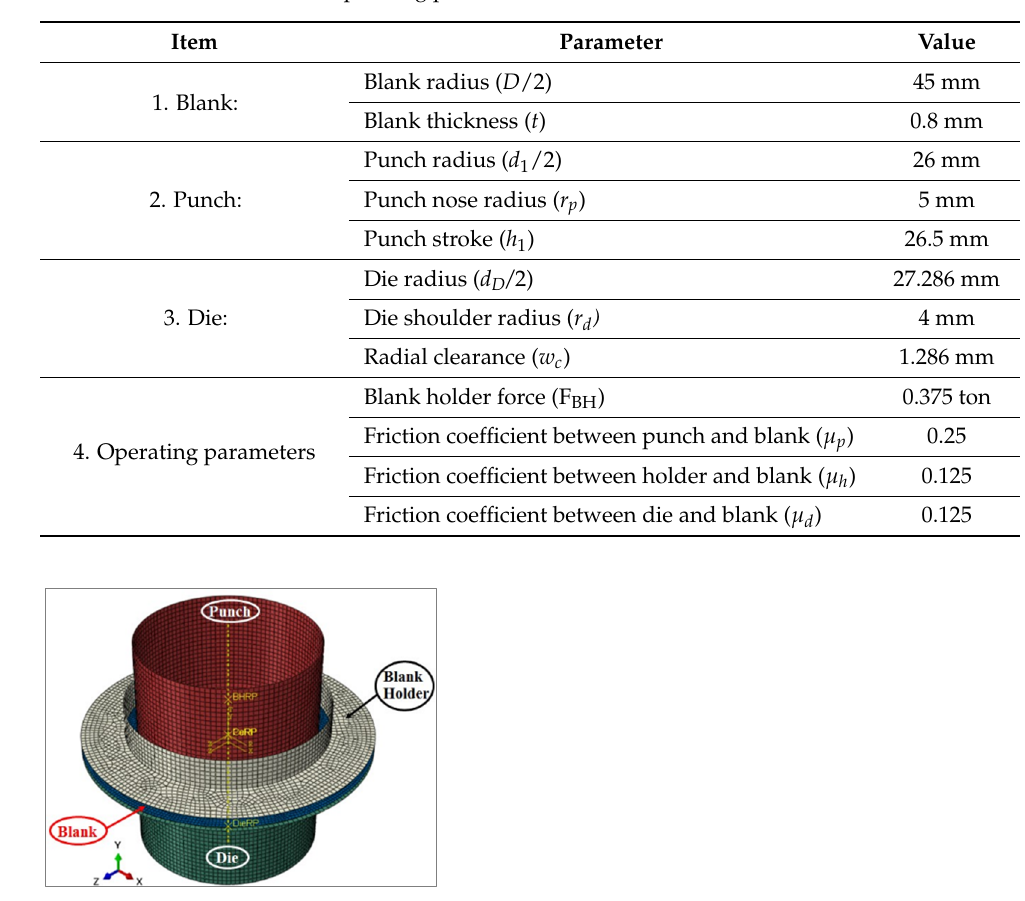
Figure 2. Assembly of the 3D finite element model (FEM) by ABAQUS.